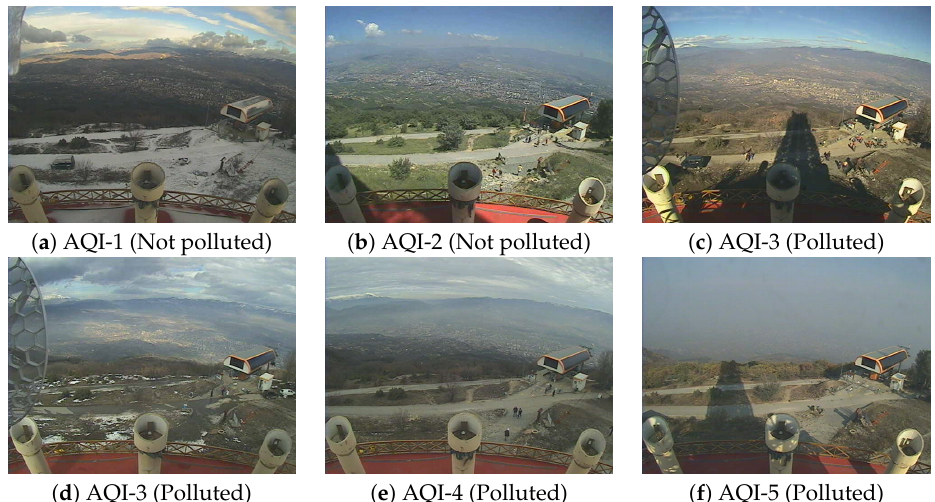
Figure 11. Exemplary images in the dataset in the different classes during the day.